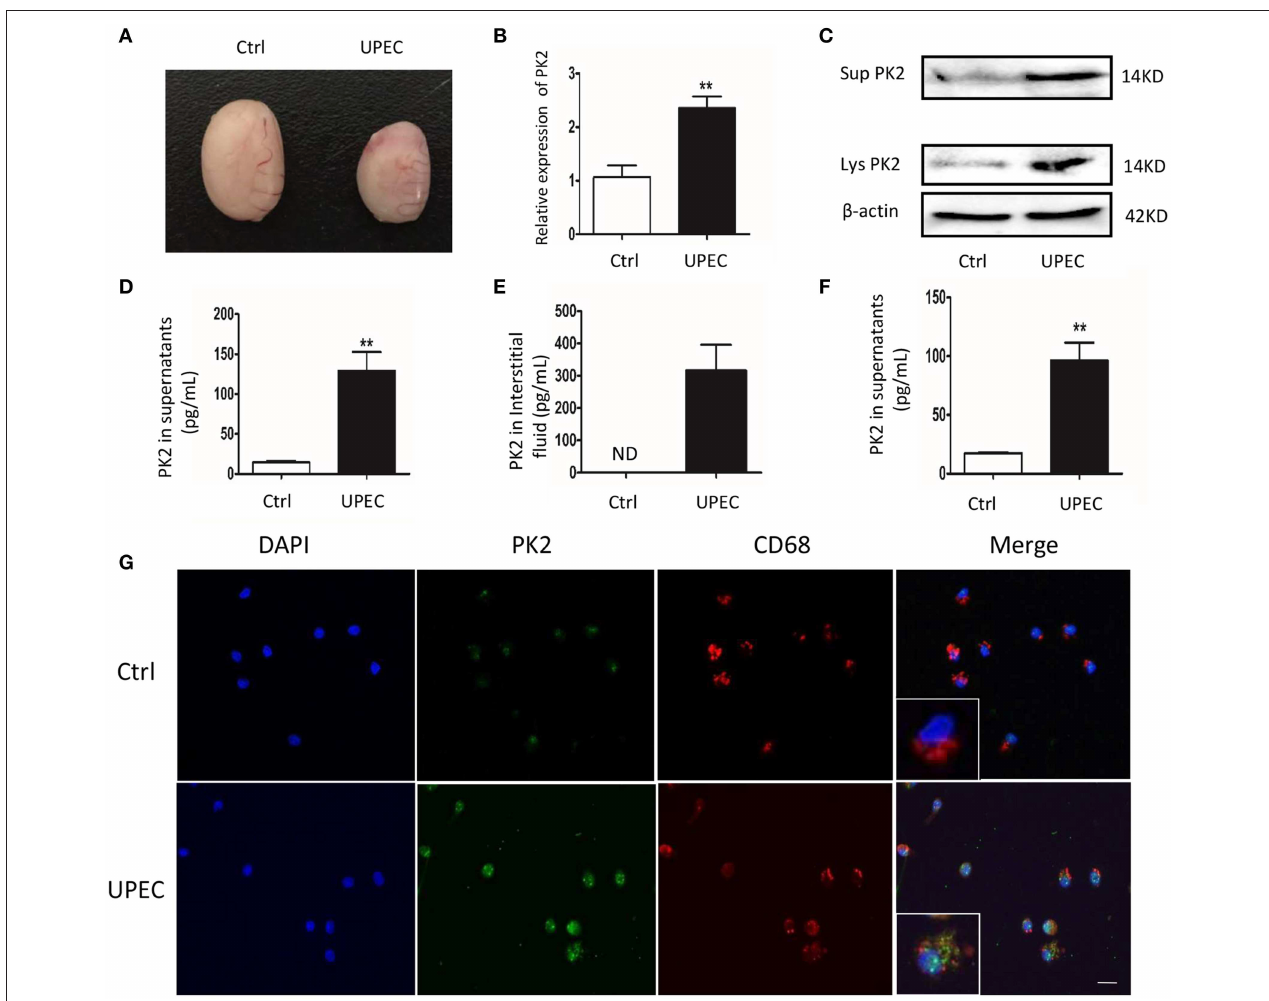
FIGURE 1 | PK2 is upregulated in TM in UPEC-induced orchitis. UPEC saline suspension was separately injected into the vas deferens proximal to the cauda epididymis, which reached the testis via a retrograde infection. Sham operated rats injected with the same volume of saline served as the control. (A) Testicular morphology, Ctrl (left) and UPEC (right) ( n = 5/group). (B) PK2 mRNA expression in TM was detected by PCR ( n = 5/group). (C) The cells were isolated from control and UPEC-treated rat testes, and then the medium was changed after the cells adhered to the wall for 1h. After a further culture for 2h, TM and the supernatants were collected. The protein level of PK2 in TM and the supernatant was analyzed by western blot. (D) The PK2 protein level in the supernatants of TM isolated from rats was analyzed by ELISA ( n = 5/group). (E) The protein level of PK2 in the testicular interstitial fluid was determined by ELISA ( n = 5/group). (F) TM were sham treated or UPEC infected (MOI, 20) for 2h in vitro . PK2 level expression in the supernatants was determined by ELISA ( n = 5/group). (G) TM were isolated from the rat testes of two groups. PK2 expression in TM was detected by immunofluorescence. Scale bar 50 µ m. Ctrl, control; Lys, cell lysates, Sup, supernatants. ** P < 0.01 ( t